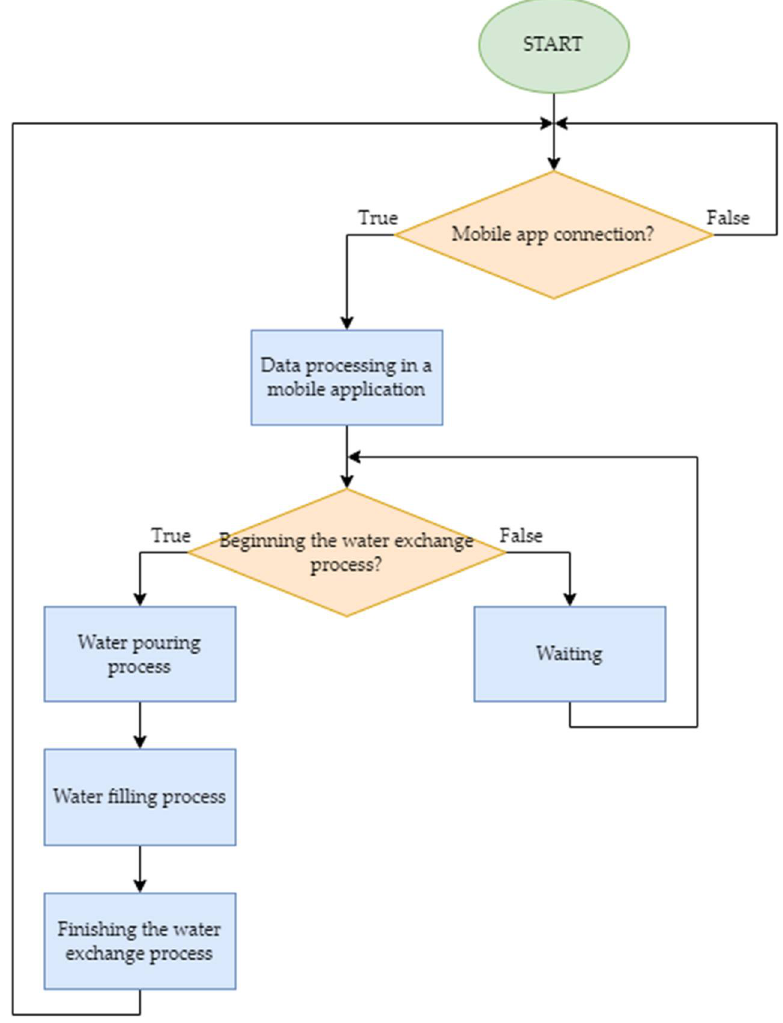
Figure 3. Simplified diagram of how the AWES works.